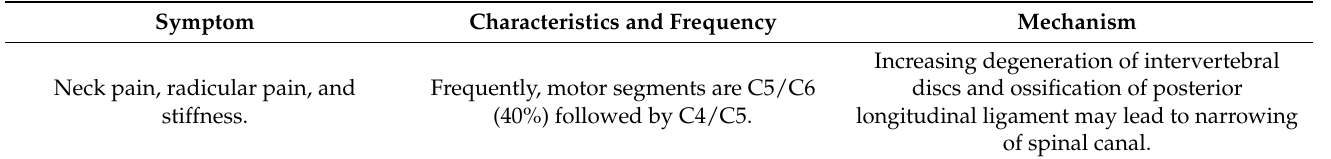
Table 2. Symptoms of cervical-spine